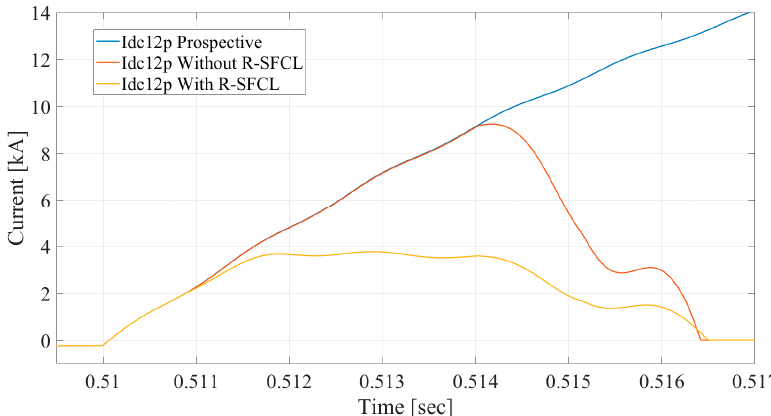
Figure 20. Link 12 positive pole fault currents for pole-to-pole fault, prospective, with M-DCCB, with M-DCCB and